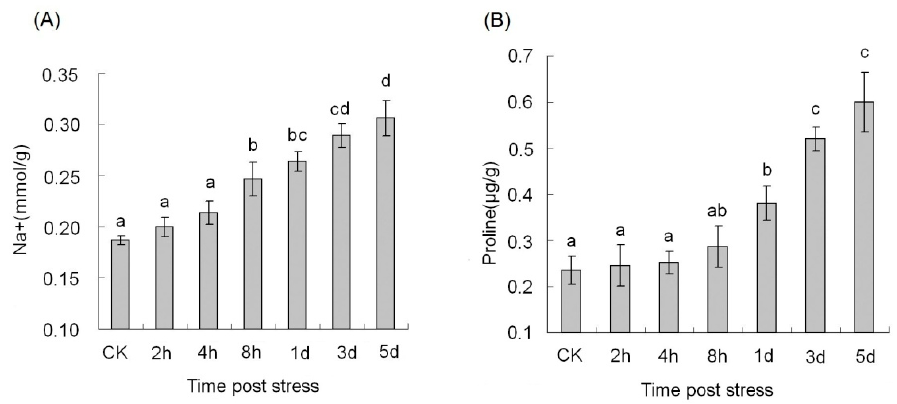
Figure 1. Measurement of Na + content and proline level under salt stress. ( A ) Na + content; ( B ) Proline content. The different letters present on the columns indicate significant differences at p < 0.01 among the control samples (CK), 4-h and 5-d salt-treatment samples. Error bars represent standard error of the mean.